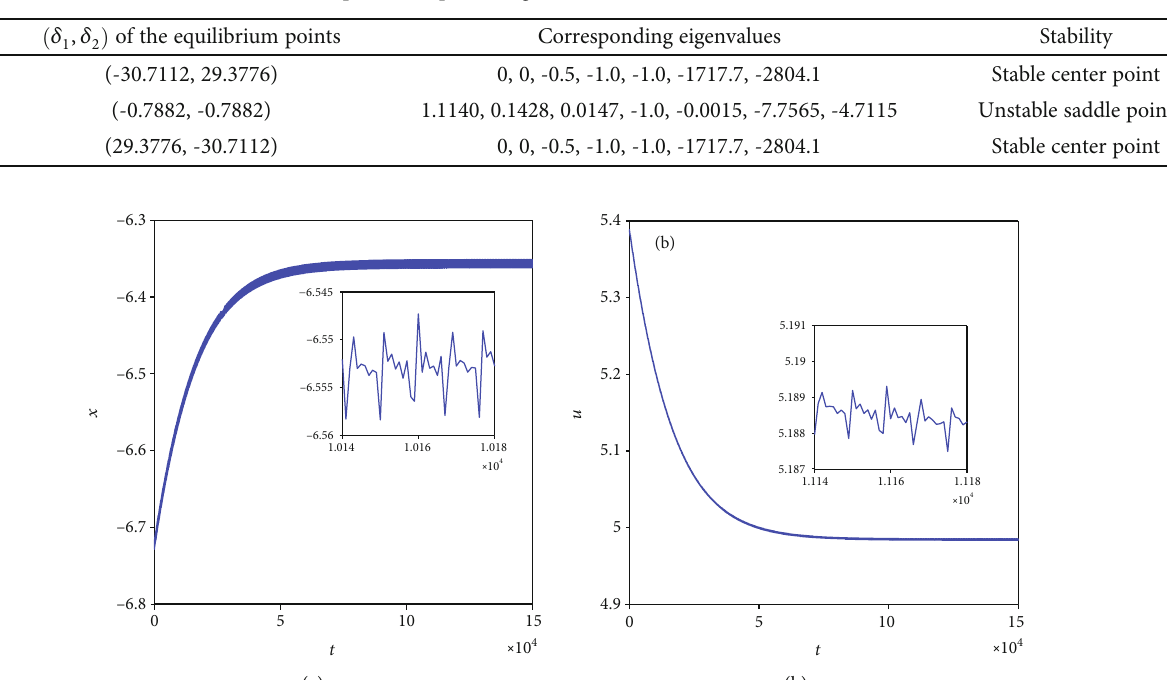
Figure 9: Firing patterns of membrane potentials in model (2) with k = 0 : 1 , I